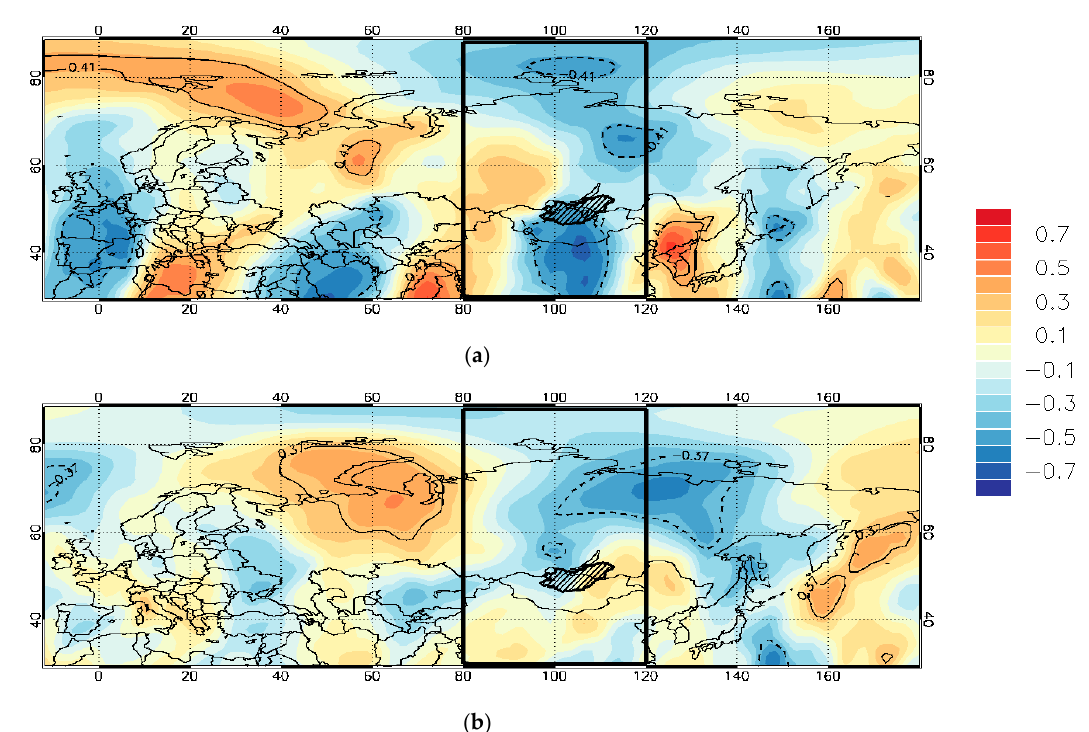
Figure 16. Correlation coefficients of ESM-blocks and V250 for 1979–1995 ( a ) and 1996–2016 ( b ). The description is the same as in Figure 8.